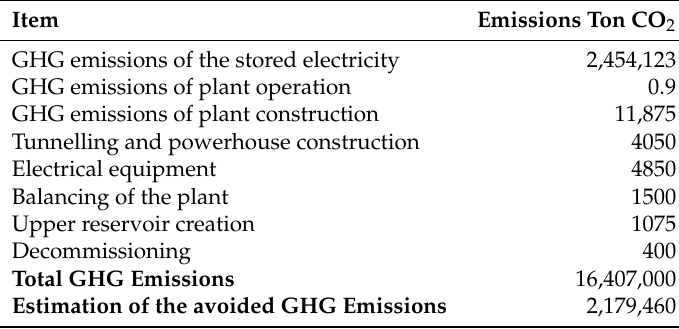
Table 5. Estimation of the GHG emissions over a 40-year